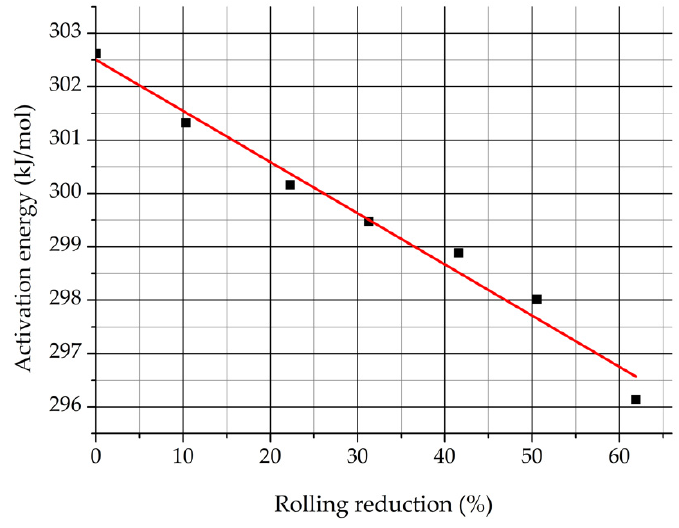
Figure 19. Activation energy in function of the rolling reduction.